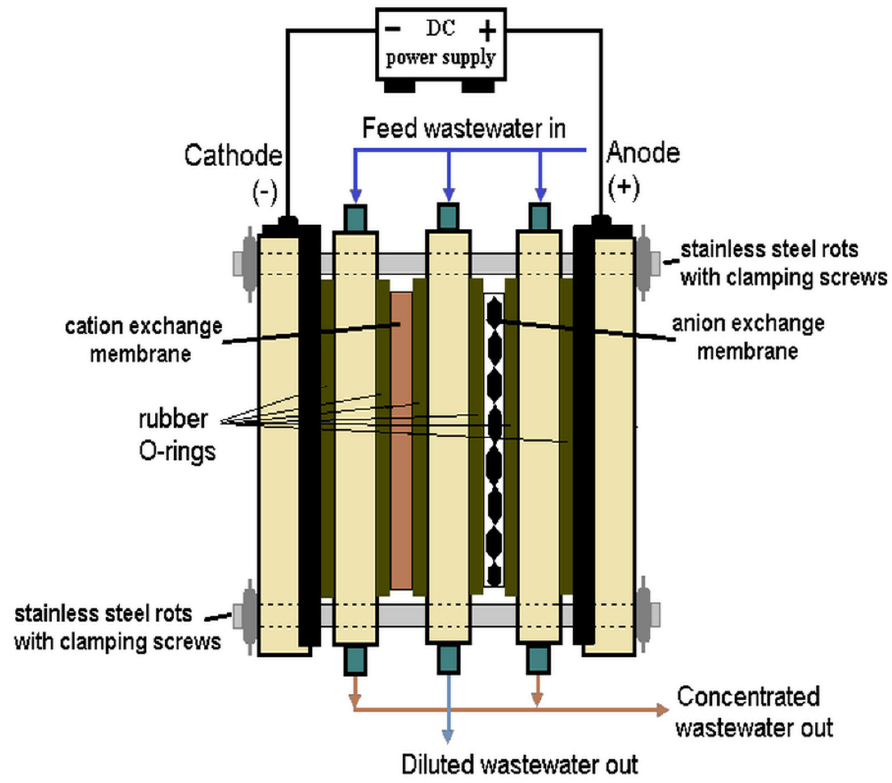
Figure 6. Schematic representation of the ED cell with three compartments.